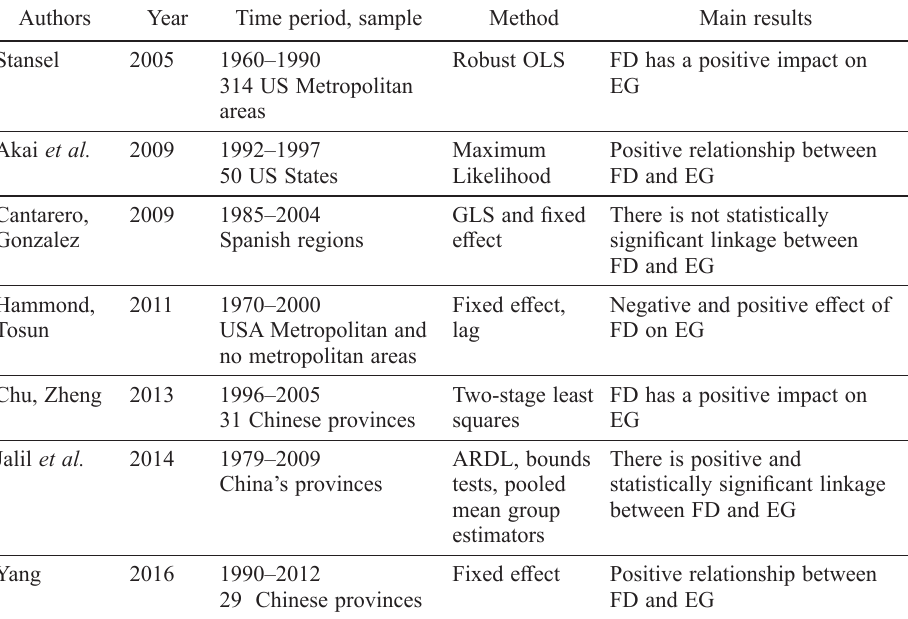
Table 2. Empirical findings in terms of federative